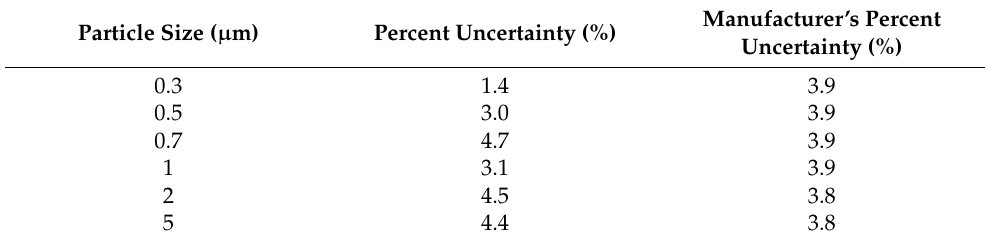
Table 3. Comparison between percent uncertainty between the current study and the manufacturer calibration of AeroTrak (TSI 9306) particle